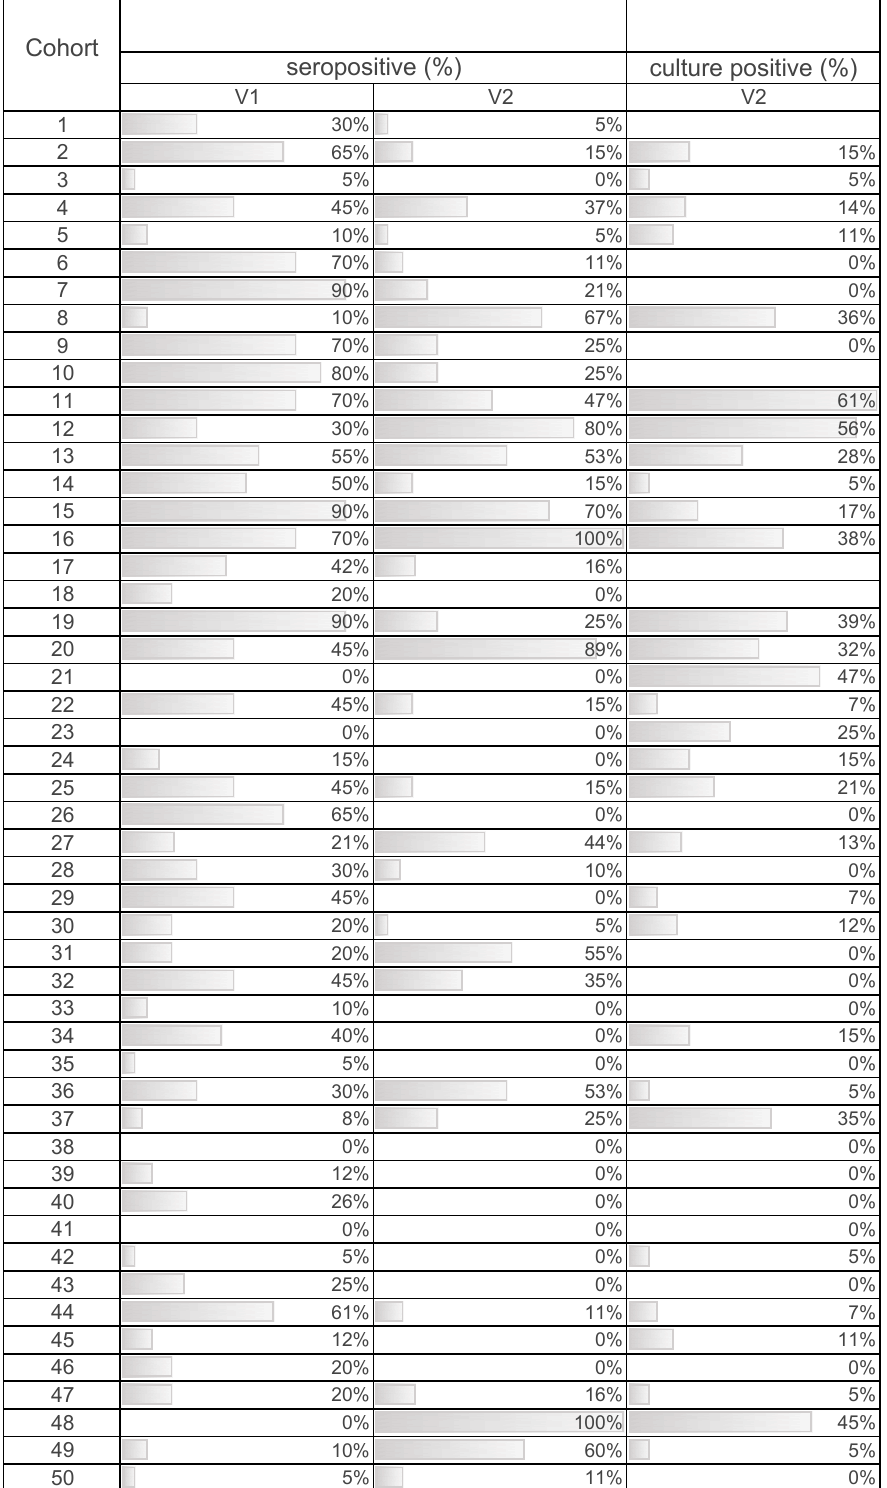
Table 3. Proportion of pigs that were Salmonella culture positive and seropositive (identified using enzyme-linked immunosorbent assay (ELISA) testing, seropositivity based on S / P ratio ≥ 0.3) at weaning (V1) and at the end of the nursery stage (V2). Data were collected from 50 swine cohorts (44 farms; 6 farms with a second cohort included in the